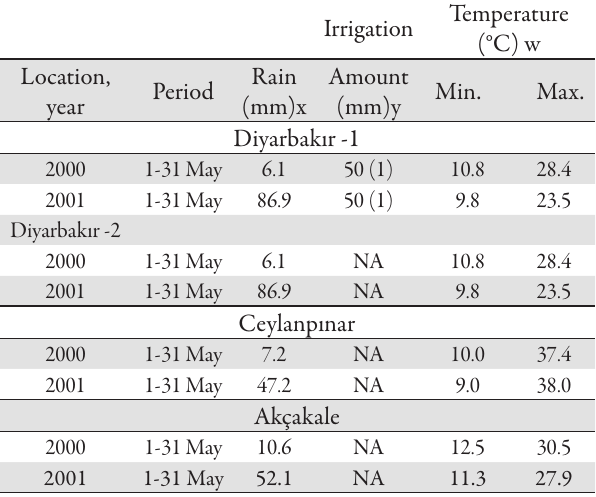
Tab. 3. Total rain and irrigation (mm) and average maximum and minimum temperatures (°C) for Diyarbakır, Ceylanpınar and Akçakale, (May) 2000 to 2001.